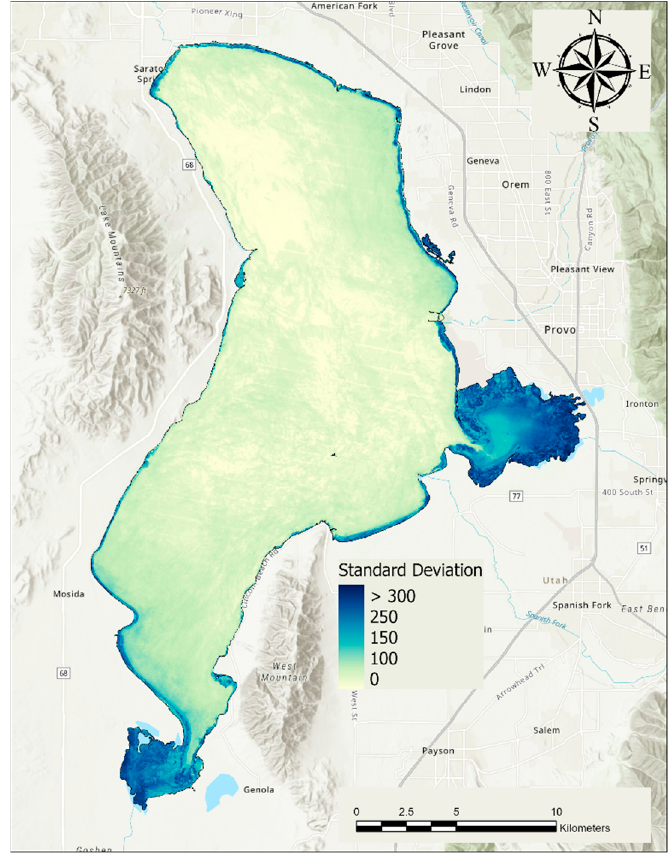
Figure 7. The standard deviation of chl-a concentration over the study period. Areas with the highest concentrations and those most impacted by water level changes have the highest standard deviation.